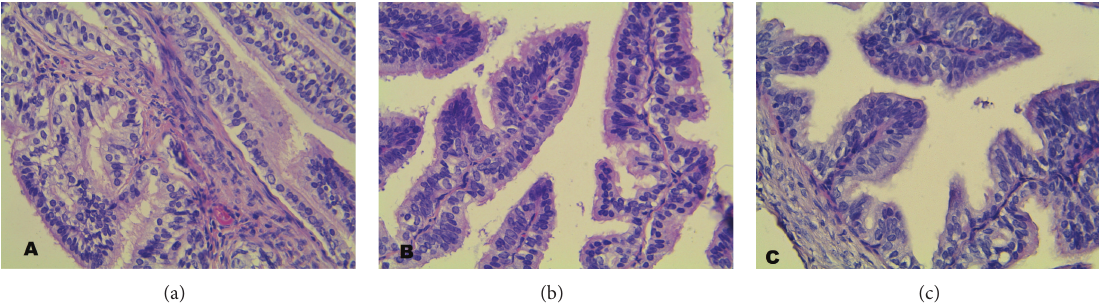
Figure 1: Section of the oviduct epithelium. C: control group, A: study group, B: study group (mag. x400), and H&E staining: The oviduct epithelium showed no discernible pathological changes.